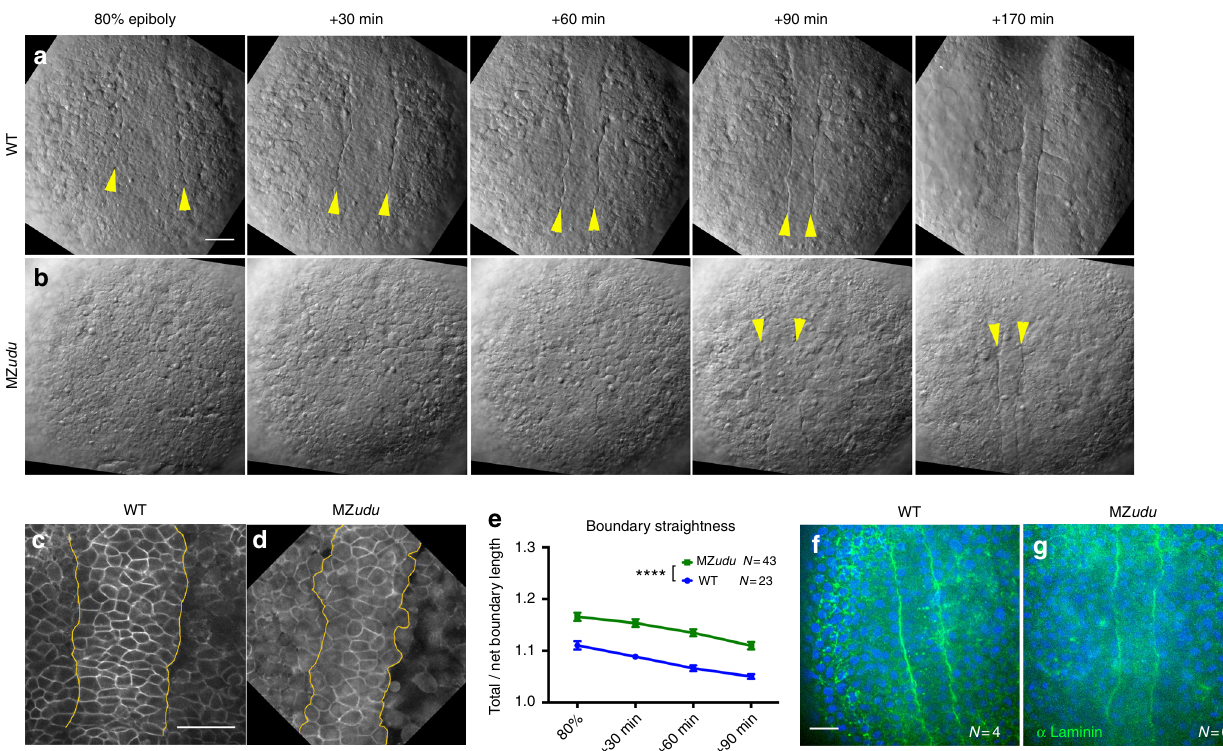
Fig. 2 MZ udu mutant gastrulae exhibit irregular notochord boundaries. a – b Still images from live Nomarski time-lapse series of the dorsal mesoderm in WT ( a ) and MZ udu − / − embryos ( b ) at the time points indicated. Images are representative of over 40 MZ udu − / − gastrulae. Arrowheads indicate notochord boundaries. c – d Live confocal microscope images of representative WT ( c , N = 23) and MZ udu − / − ( d , N = 43) embryos expressing membrane Cherry. Yellow lines mark notochord boundaries. e Quanti fi cation of notochord boundary straightness in live WT and MZ udu − / − gastrulae throughout gastrulation. Symbols are means with SEM (two-way ANOVA, **** p < 0.0001). f – g Confocal microscope images of immuno fl uorescent staining for pan-Laminin in WT ( f ) and MZ udu − / − ( g ) embryos at two-somite stage. N indicates the number of embryos analyzed. Scale bars are 50 μ m. Anterior is up in all